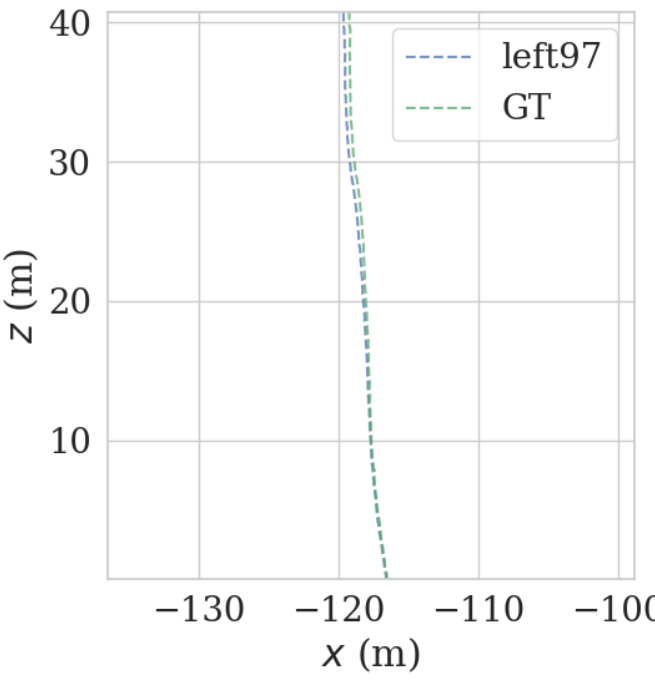
Figure 21. Track error using front-left LiDAR data on the straight track.